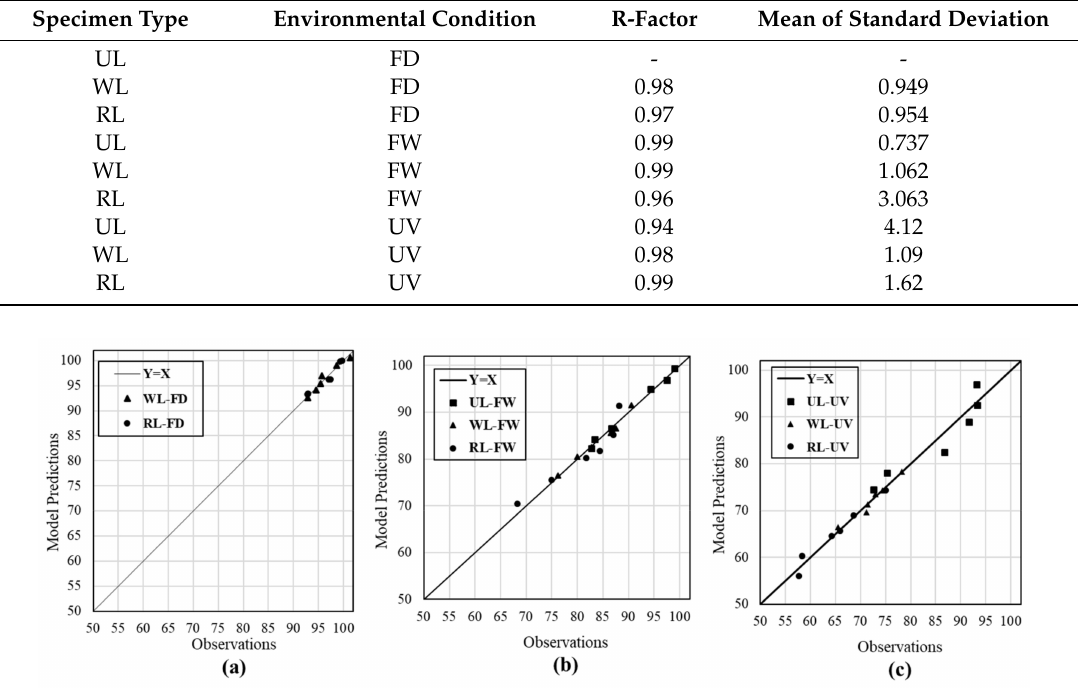
Table 6. Bayesian regression parameters for FD condition.